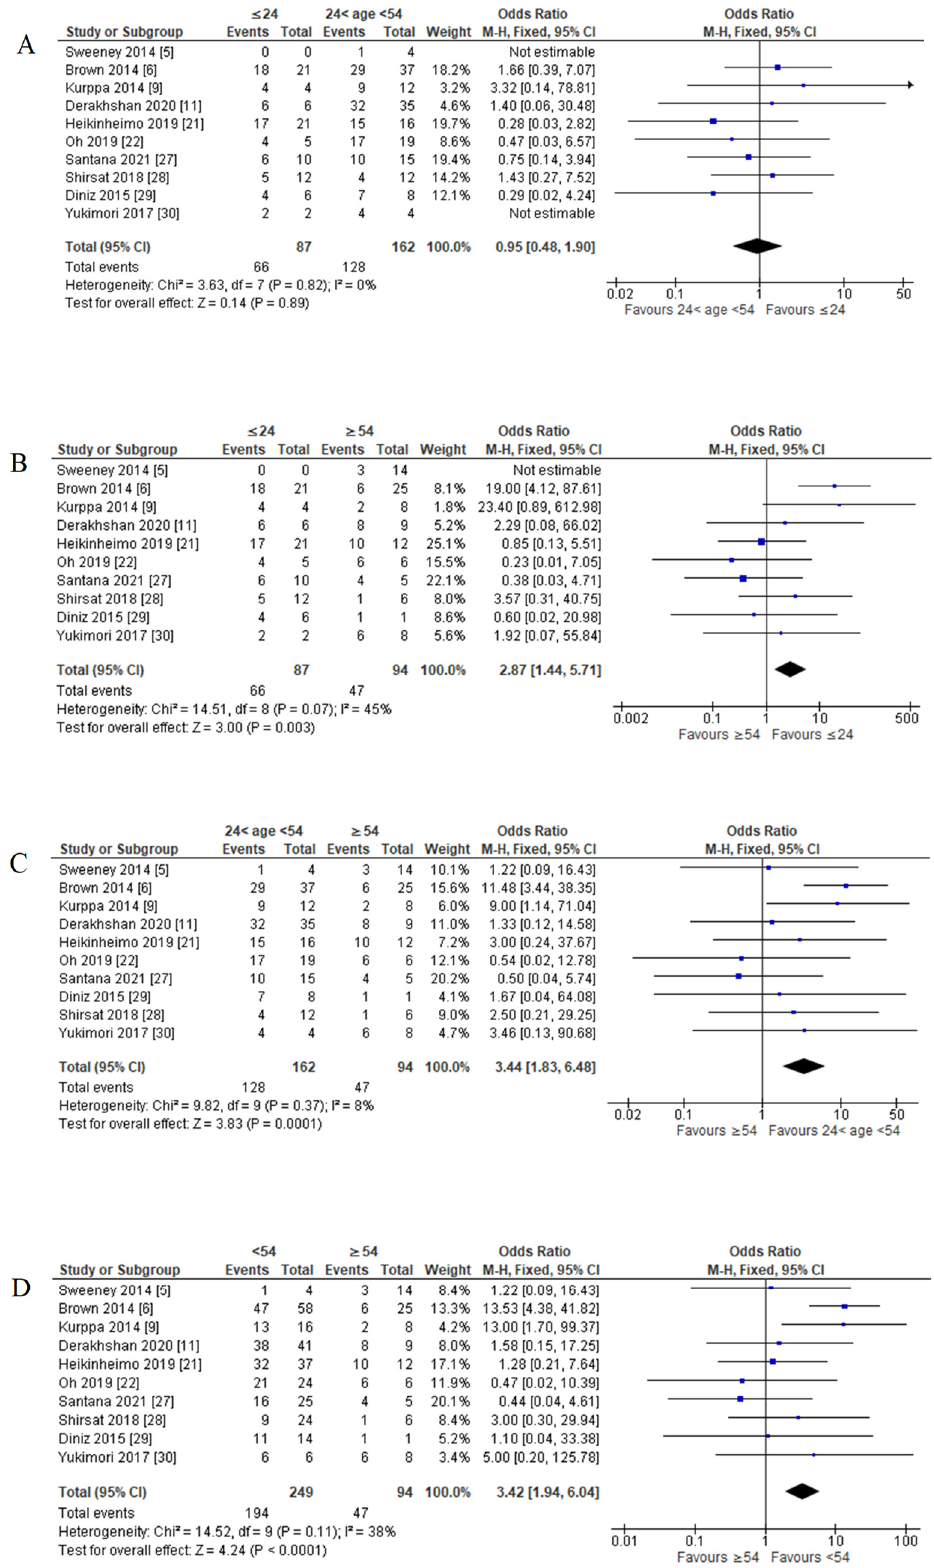
Figure 4. Forest plot of age groups with BRAF V600E mutation in ameloblastoma cases. ( A ) Young age group versus adult age group; ( B ) young age group versus older age group; ( C ) adult age group versus older age group; ( D ) young and adult age group versus older age group.